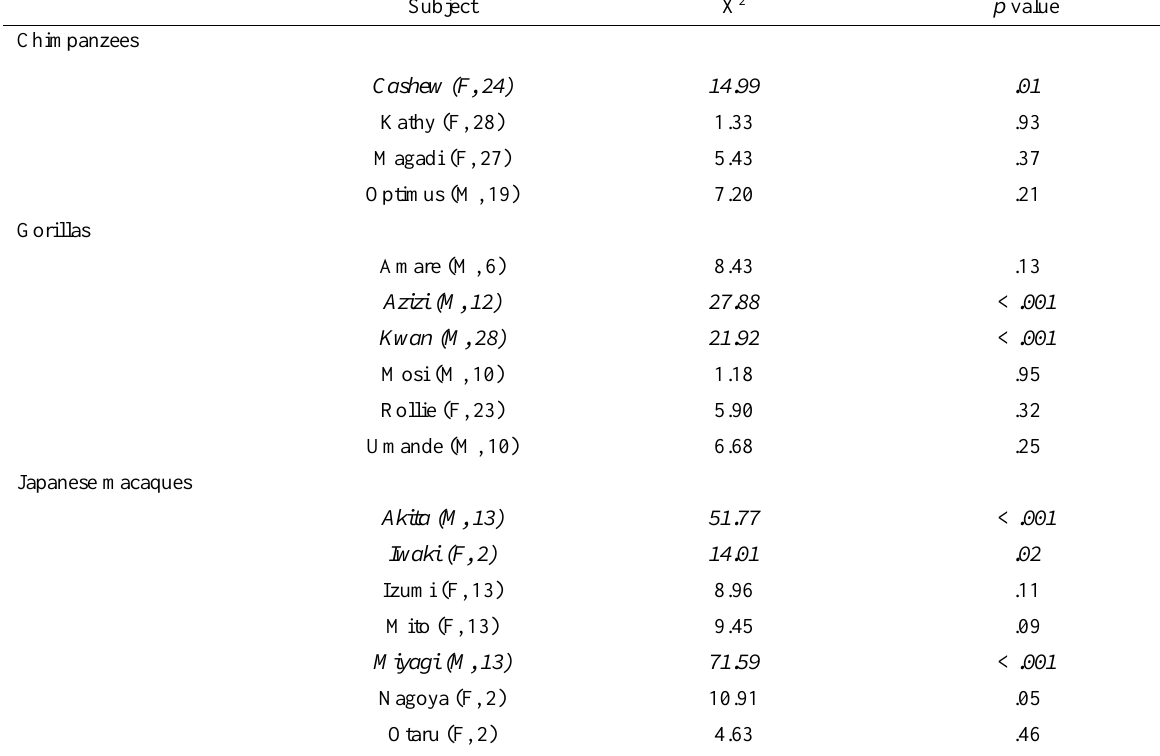
Comparisons of subjects’ worth values for the six foods when presented in a blocked manner of 90 trials per pairing (data previously published in Huskisson et al., 2020) to worth values calculated from the subjects’ selection rates in Phase 1 of the present study in which we presented all pairings in a randomized manner across